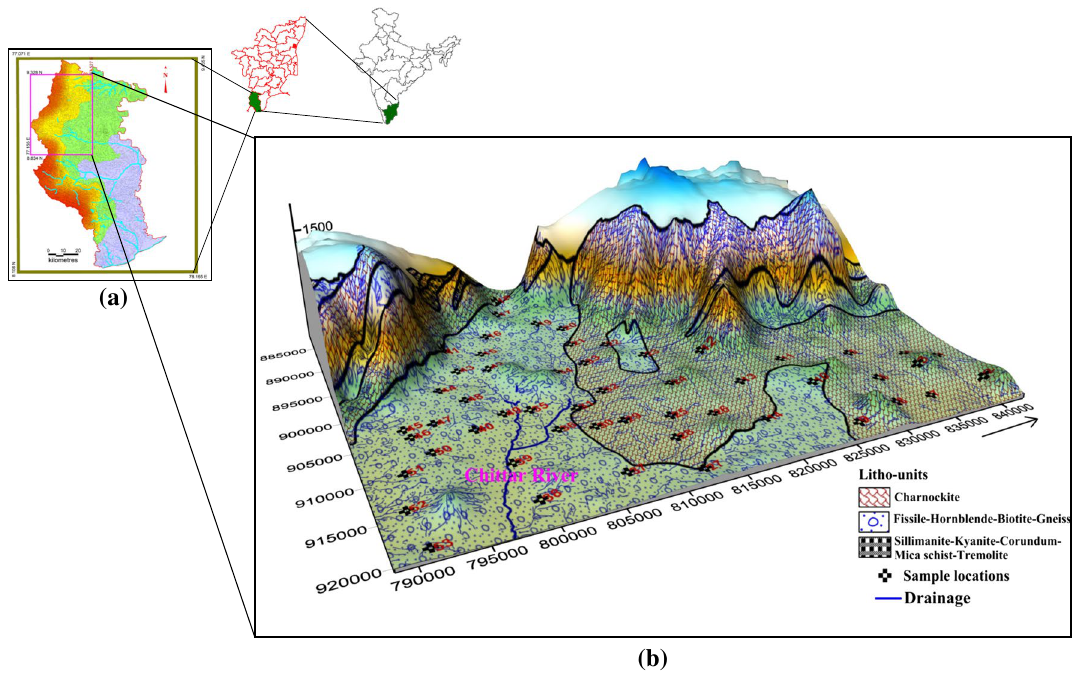
Fig. 1 Location map of the study area a elevation map in 2D view, b elevation map in 3D view along with lithology, drainage and sample loca-